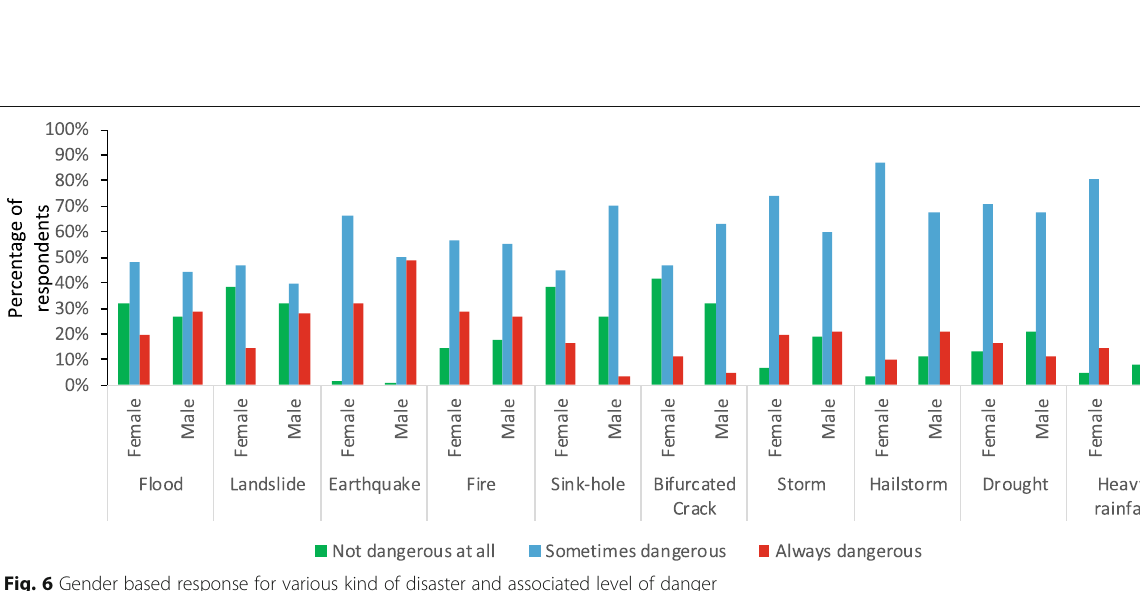
Fig. 6 Gender based response for various kind of disaster and associated level of danger